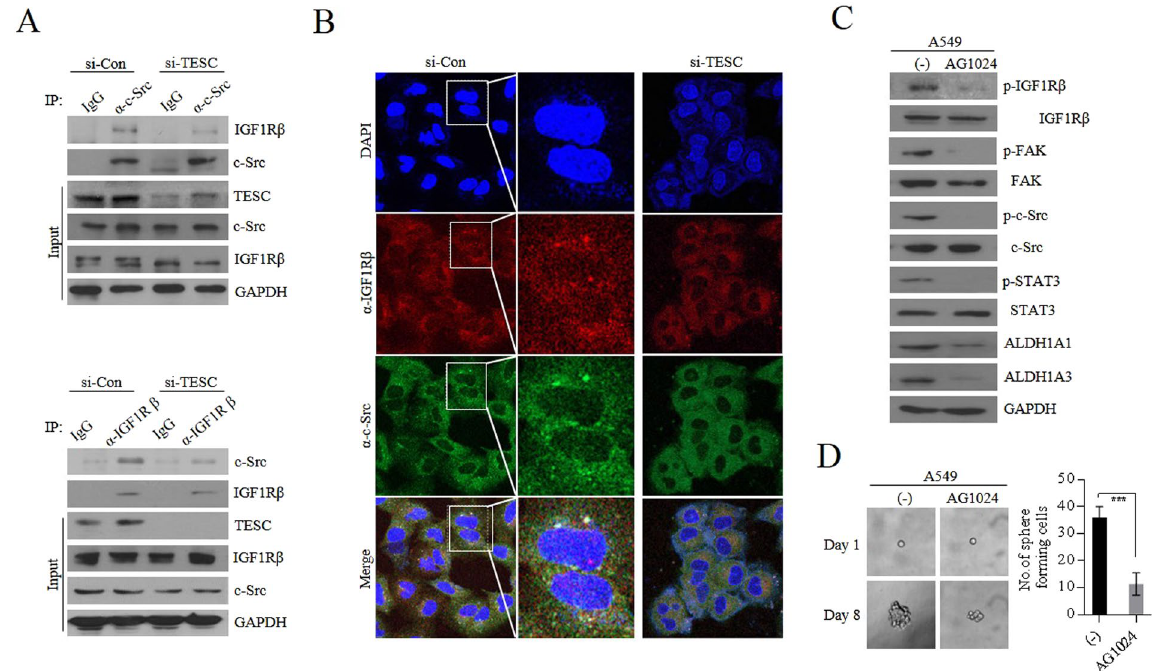
Figure 5. TESC mediates the reciprocal activation between c-Src and IGF1R. ( A ) Immunoprecipitation analysis of interaction between c-Src and IGF1R β in TESC -knockdown A549 NSCLC cells. ( B ) Confocal analysis of interaction between c-Src and IGF1R β in TESC -knockdown A549 cells. ( C ) Phosphorylation levels of c-Src, FAK and STAT3 in IGF1R-inactivated A549 cells. For the inhibition of IGF1R activation, A549 cells were treated with 10 μ M AG1024, a representative IGF1R inhibitor, for 24 h. ( D ) Changes of sphere formation